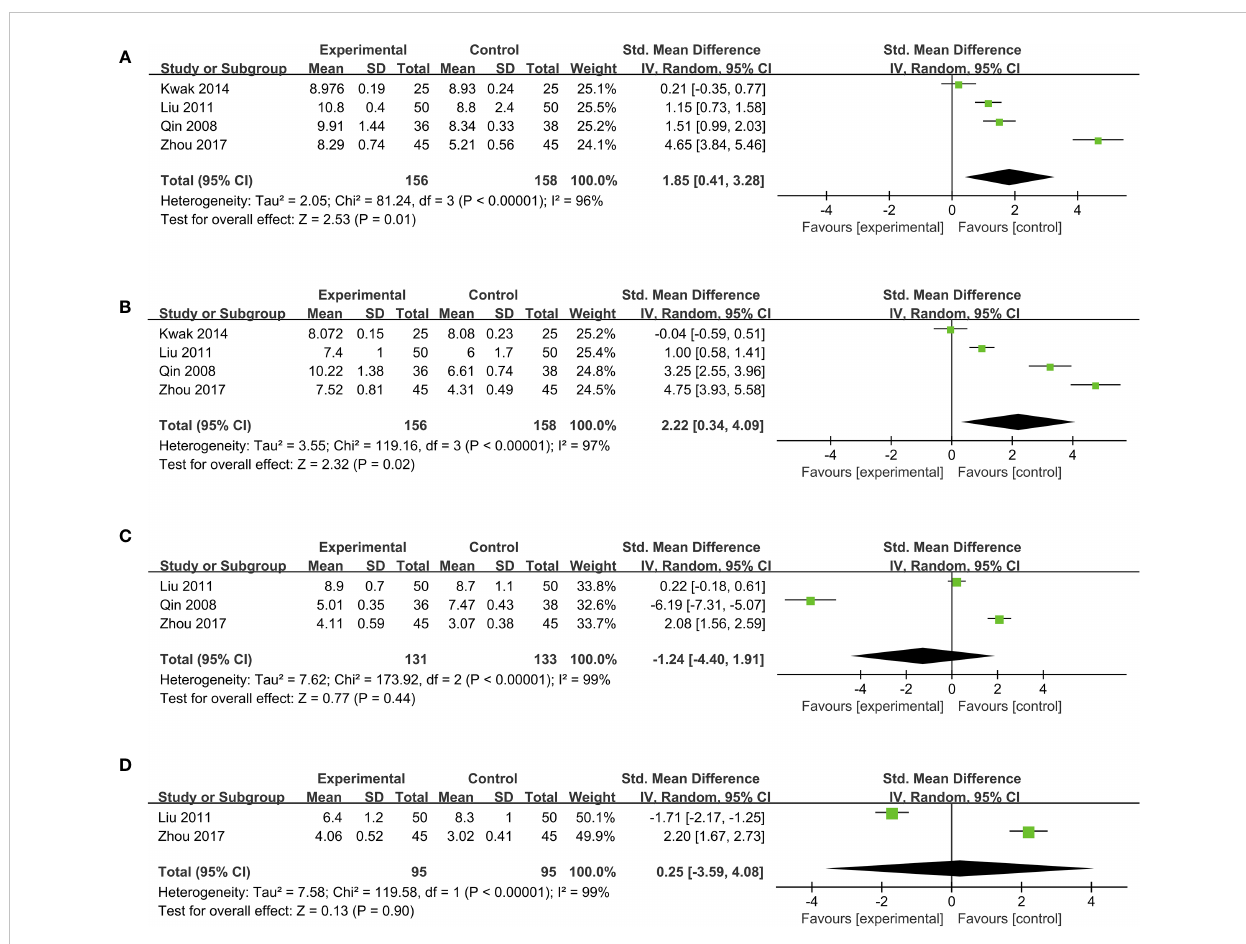
FIGURE 5 Forest plots of pooled data on the effect of probiotics on microbial abundance. (A) Bi fi dobacterium , (B) Lactobacillus , (C) Enterococcus , (D) Enterobacteriaceae